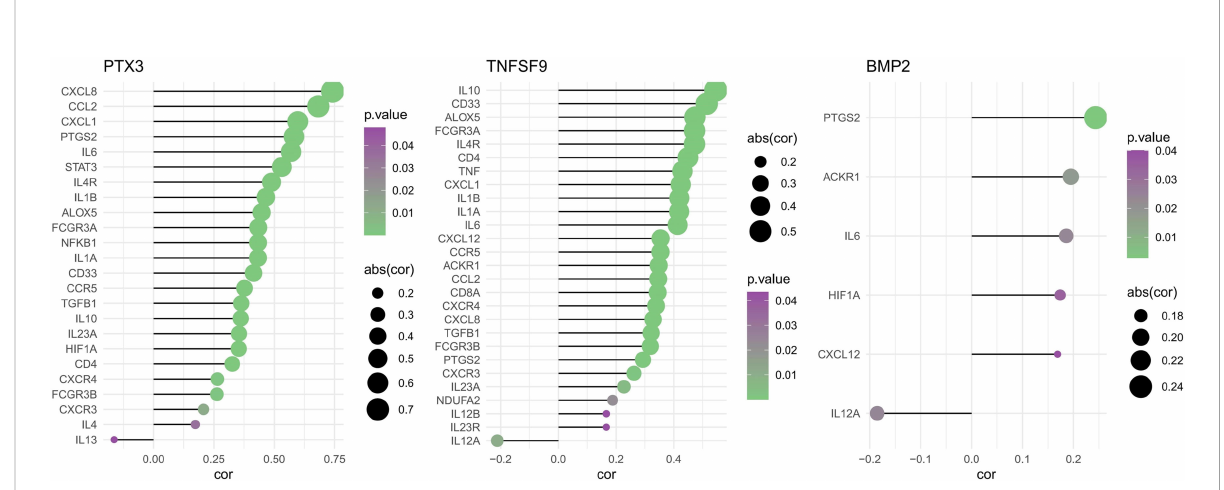
FIGURE 11 Spearman correlations of three model genes and in fl ammatory factors ( P <